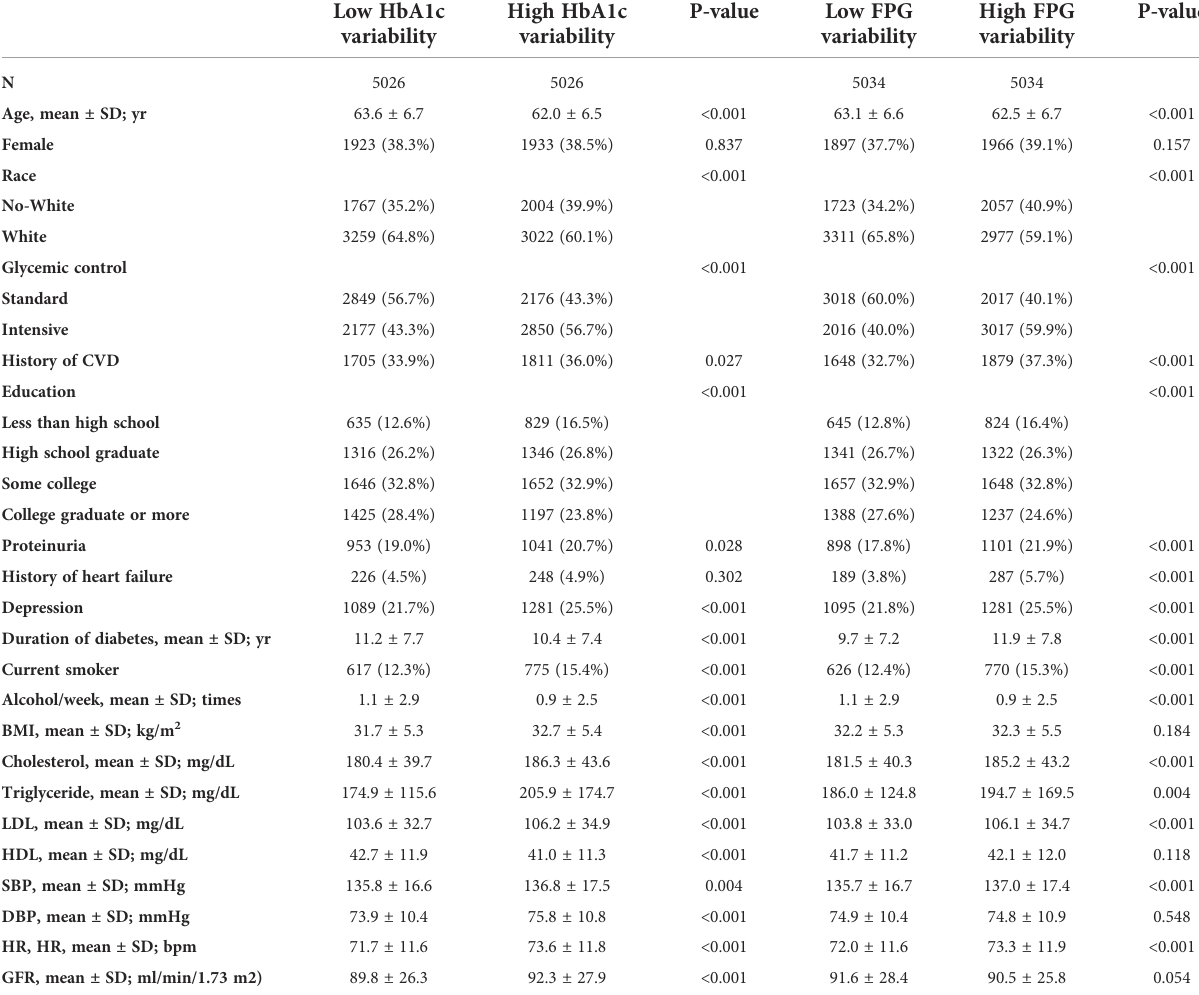
TABLE 1 Baseline characteristics of included